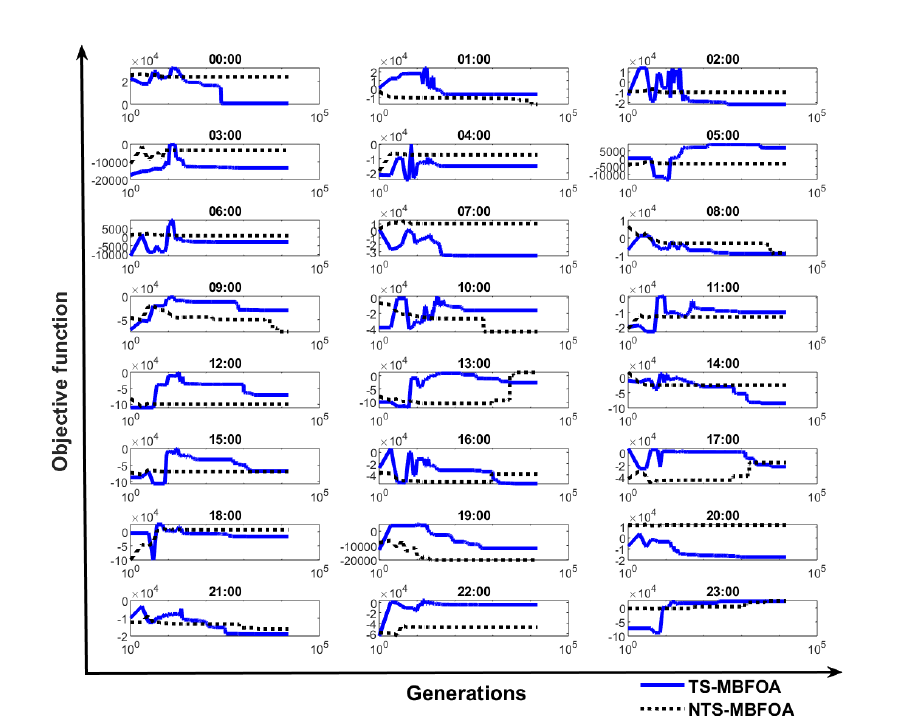
Figure 4. Convergence graph of TS-MBFOA and NTS-MBFOA in the independent run number 15.